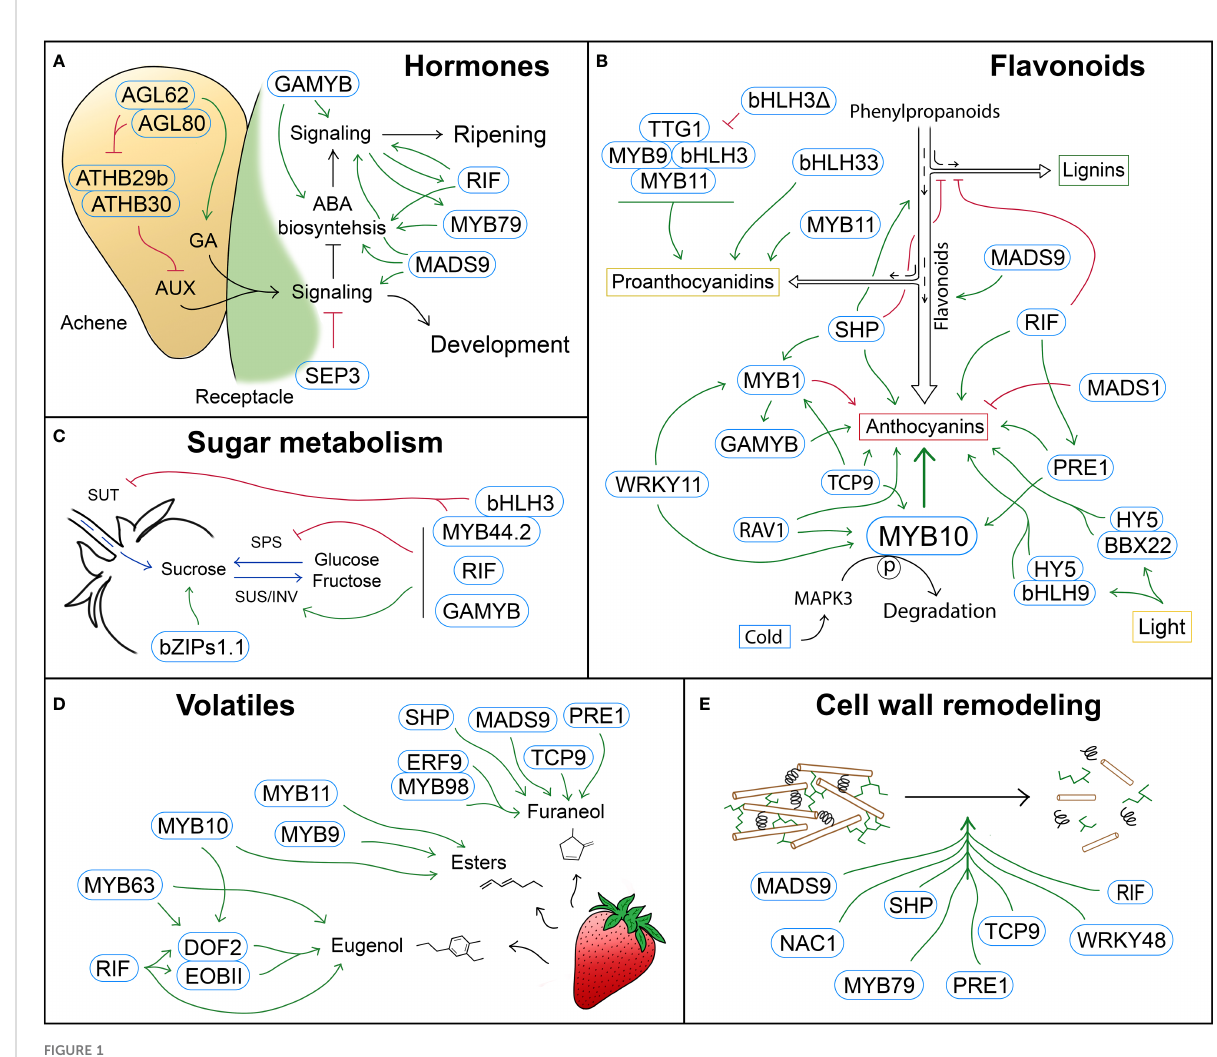
FIGURE 1 Schematic representation of TFs with a role in different strawberry ripening-related processes. (A) Hormone biosynthesis and signaling are regulated by complex GNRs that govern the switch from the development stages, in which auxin (AUX) and gibberellic acid (GA) promote cell fruit division and expansion, to the ripening stages, which are mainly regulated by abscisic acid (ABA). (B) Regulation of the phenylpropanoid pathway by TFs that control metabolic fl uxes and modulate different branches of the pathway, such as the lignin, proanthocyanidin or anthocyanin pathways. (C) TFs involved in the regulation of sugar metabolism (SPS, SUS and INV) and transport (SUT). (D) TFs controlling the biosynthesis of volatile compounds, mainly esters, as well as furaneol and eugenol. (E) TFs regulating cell wall modi fi cation, and therefore fruit softening during ripening. Blue rounded rectangles indicate TFs. Green arrows and red block symbols denote positive and negative regulation